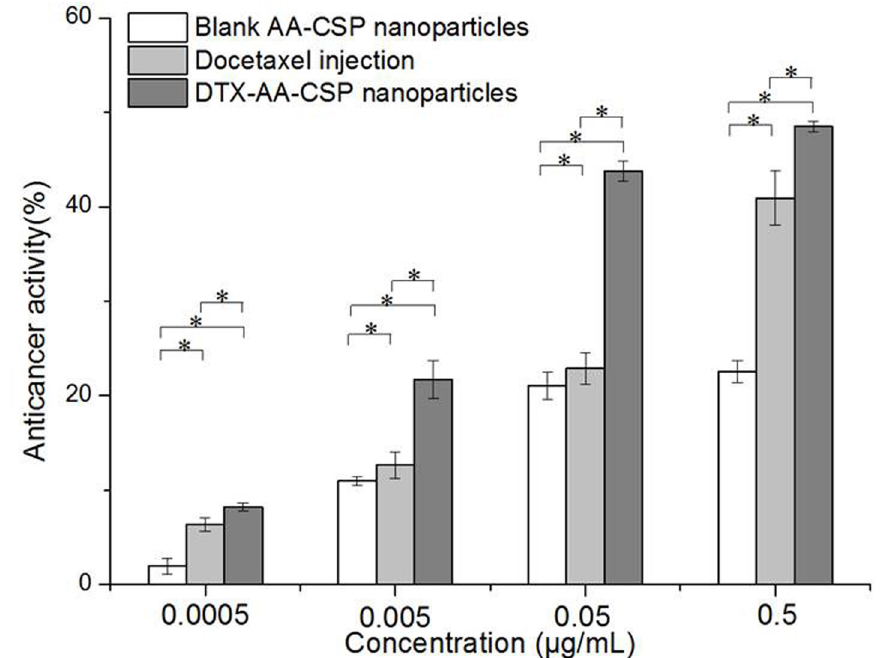
FIGURE 10 - Anticancer activity of AA-CSP nanoparticles, docetaxel injection (Taxotere ® ) and DTX-AA-CSP nanoparticles on HepG2 cells after 48 h incubation (* p <